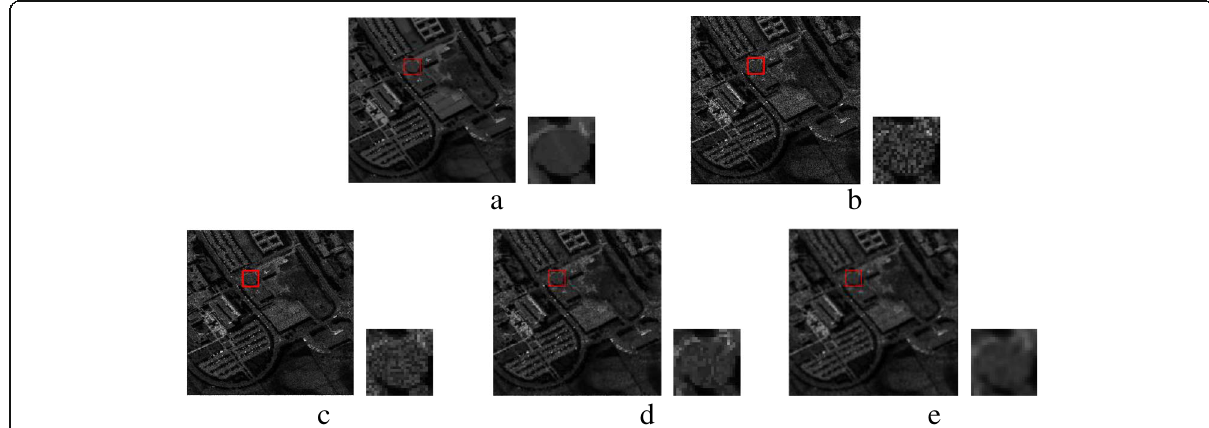
Fig. 8 Recovered SAR images and zoomed square region marked by red-lined boxes via different methods. a Original image, b noisy image (PSNR = 24.4431, SSIM = 0.7095), c nonlocal-AA method (PSNR = 25.9805, SSIM = 0.7919), d nonlocal-SO method (PSNR = 26.1081, SSIM = 0.8423), and e proposed method (PSNR = 27.0234, SSIM =